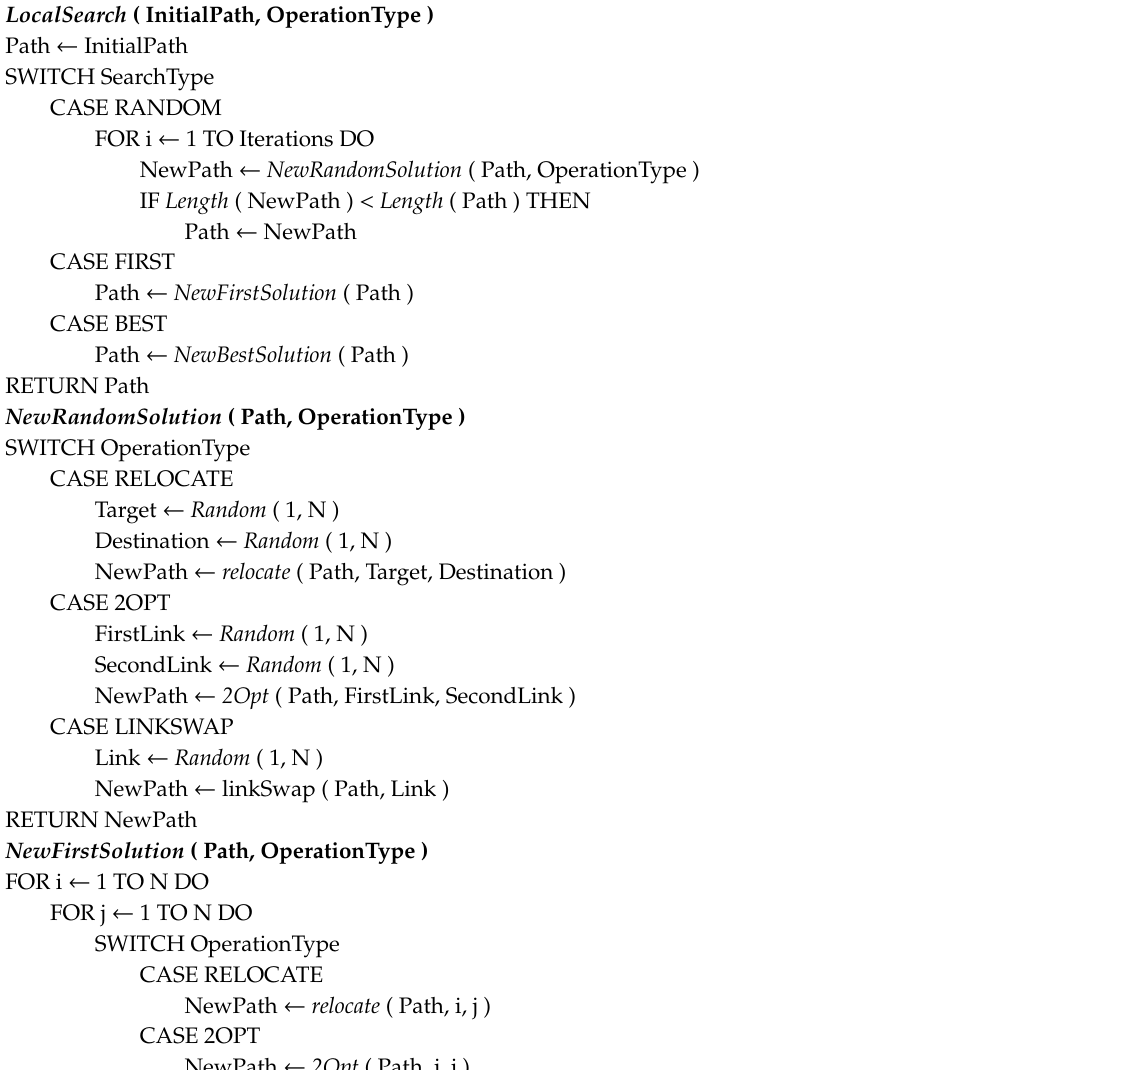
Algorithm 2: Finding the improved tour by all the operators for di ff erent search strategies LocalSearch ( InitialPath, OperationType